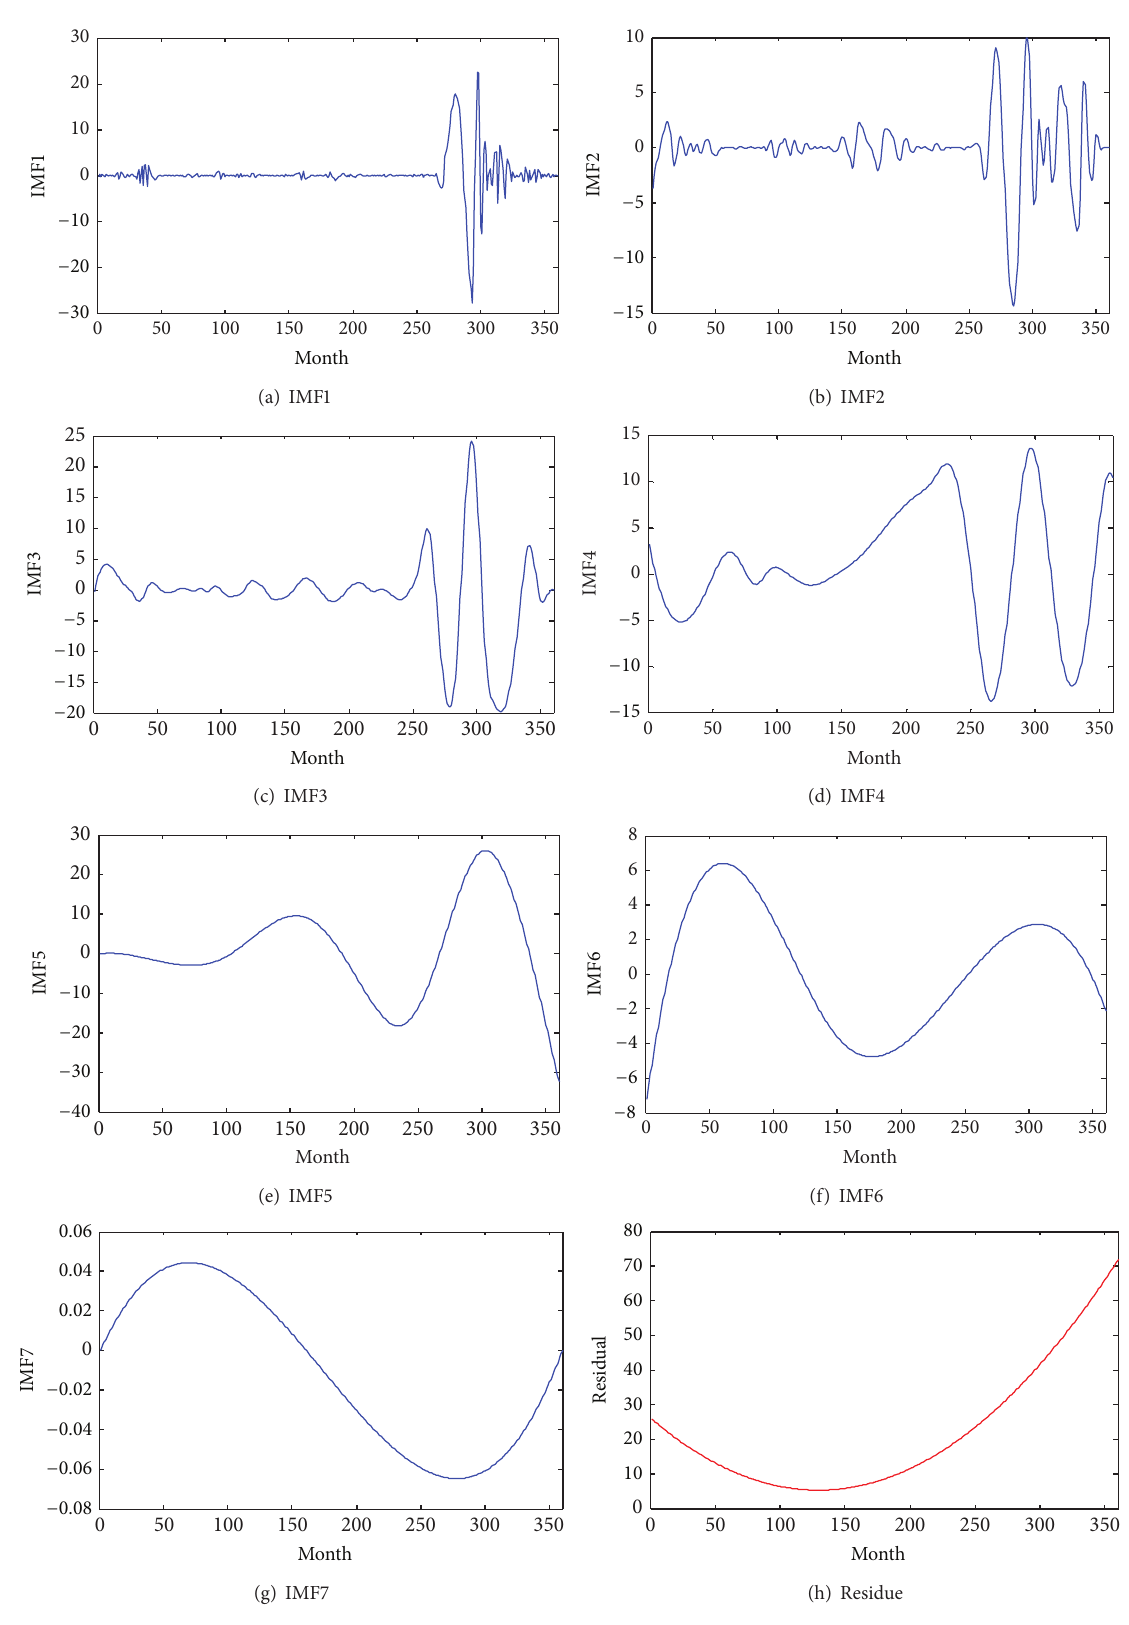
Figure 5: The IMFs and residue for uranium resource price monthly data